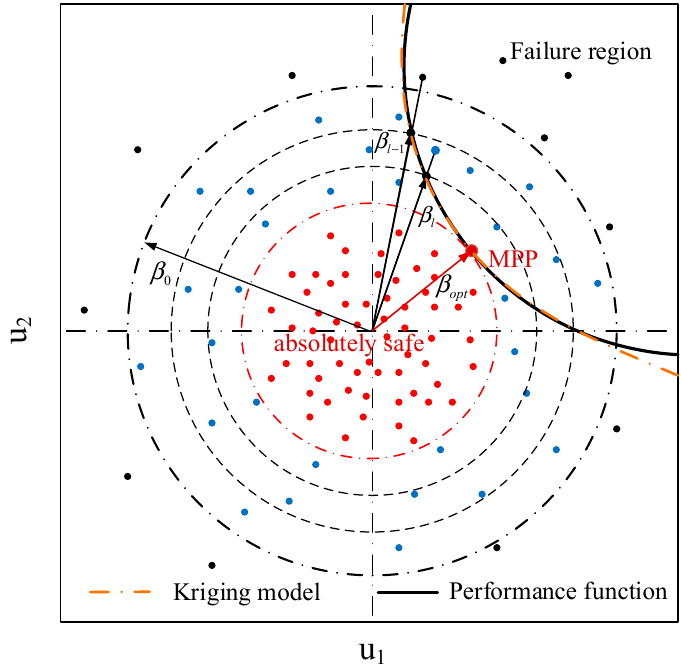
Figure 9. Schematic diagram of AK-ARBIS.